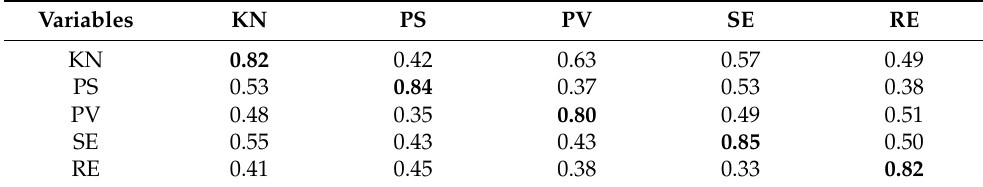
Table 2. Discriminant validity